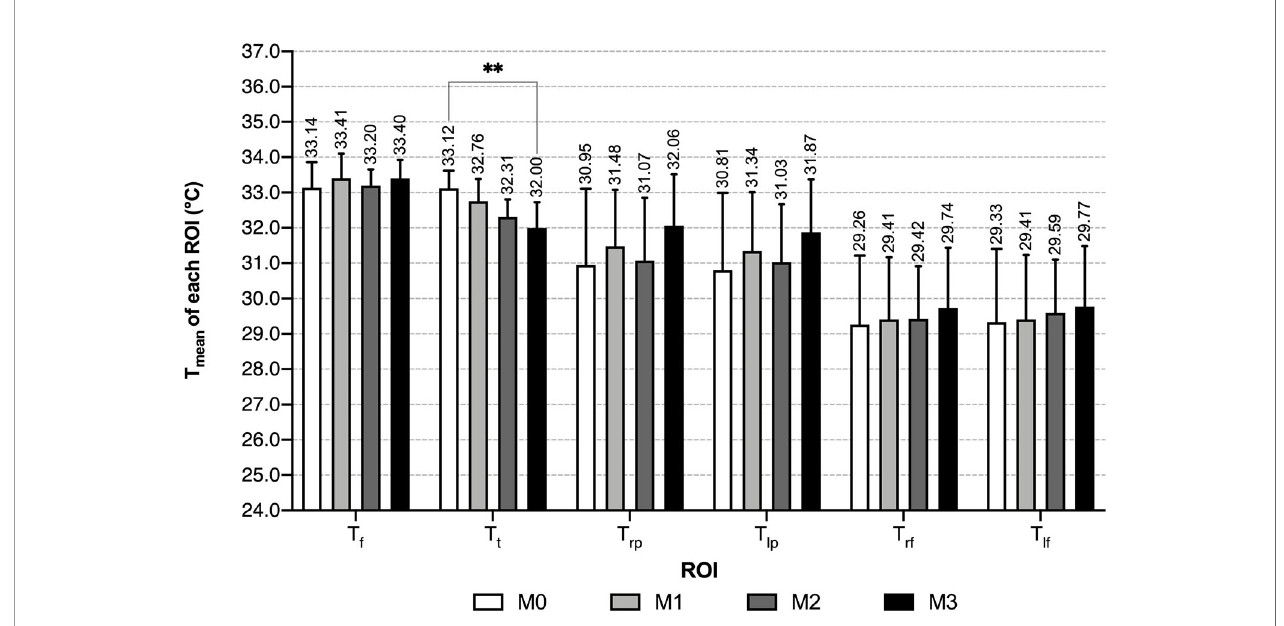
FIGURE 5 | T mean of each ROI of male groups - grouped by ROI. **: P < 0.01.